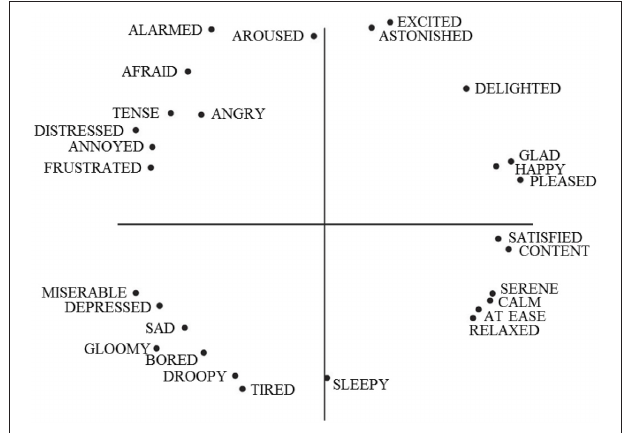
FIGURE 1 | The circumplex model of affect. From “A circumplex model of affect” by Russell